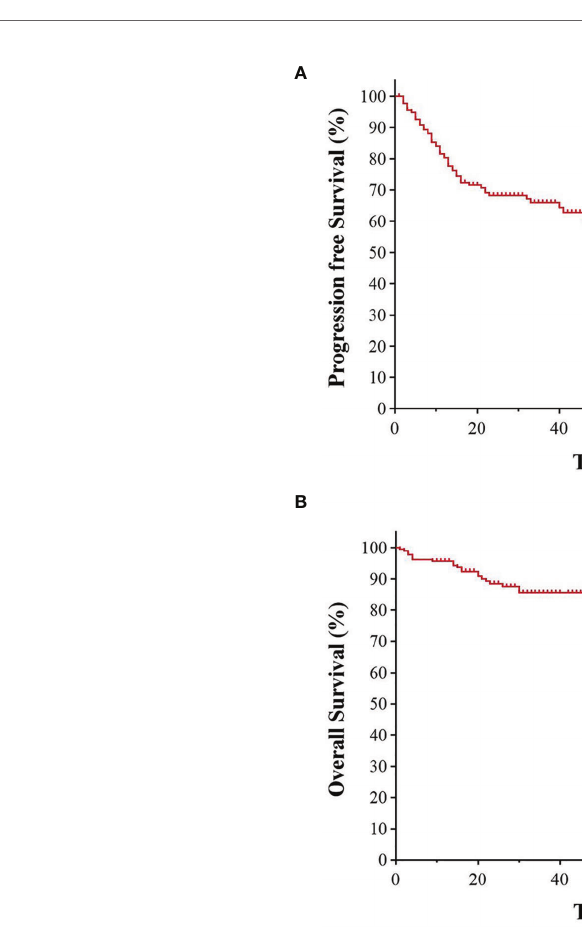
FIGURE 1 | Kaplan – Meier survival curve of UAT-ENKTL patients. Overall survival (A) and progression-free survival (B) in the total 182 of UAT-ENKTL patients. ENKTL, natural killer/T-cell lymphoma, nasal type; UAT, upper aerodigestive